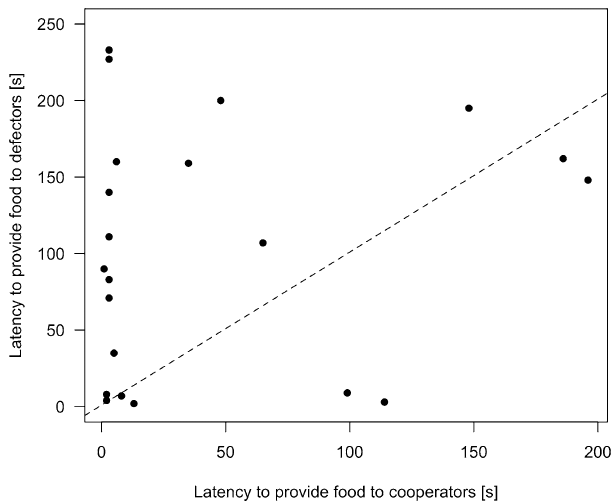
Figure 3. Latencies to first food pulling of focal rats for their previously cooperating partner vs . for their previously defecting partner. The previous helpfulness of the partner influenced the latency (in seconds) of test subjects to provide the first food reward to its partner. Every data point represents the focal individual’s latency to the first food provisioning of the cooperating partner compared with that of the defecting partner. Data points above the dashed line represent focal individuals who pulled earlier for the cooperating partner than for the defecting partner. This is inversed for data points below the dashed line. Significantly more focal individuals pulled earlier for their cooperating partner than for the defecting partner.